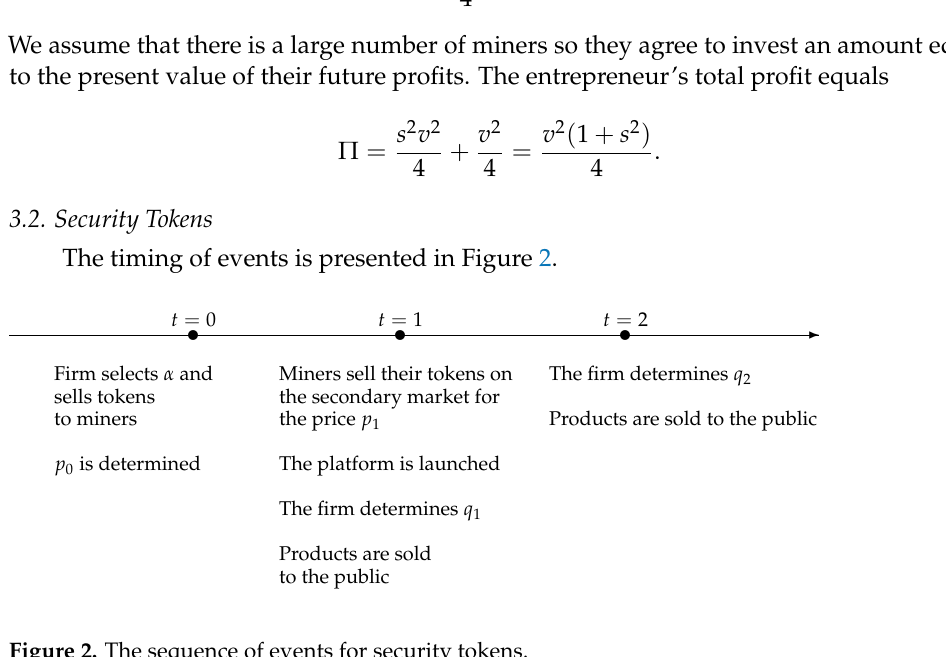
Figure 2. The sequence of events for security